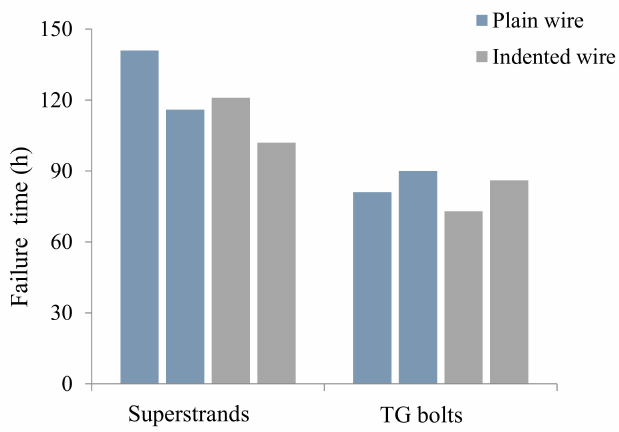
Figure 14. The failure time of the last wire of full-scale cable-bolt specimens.